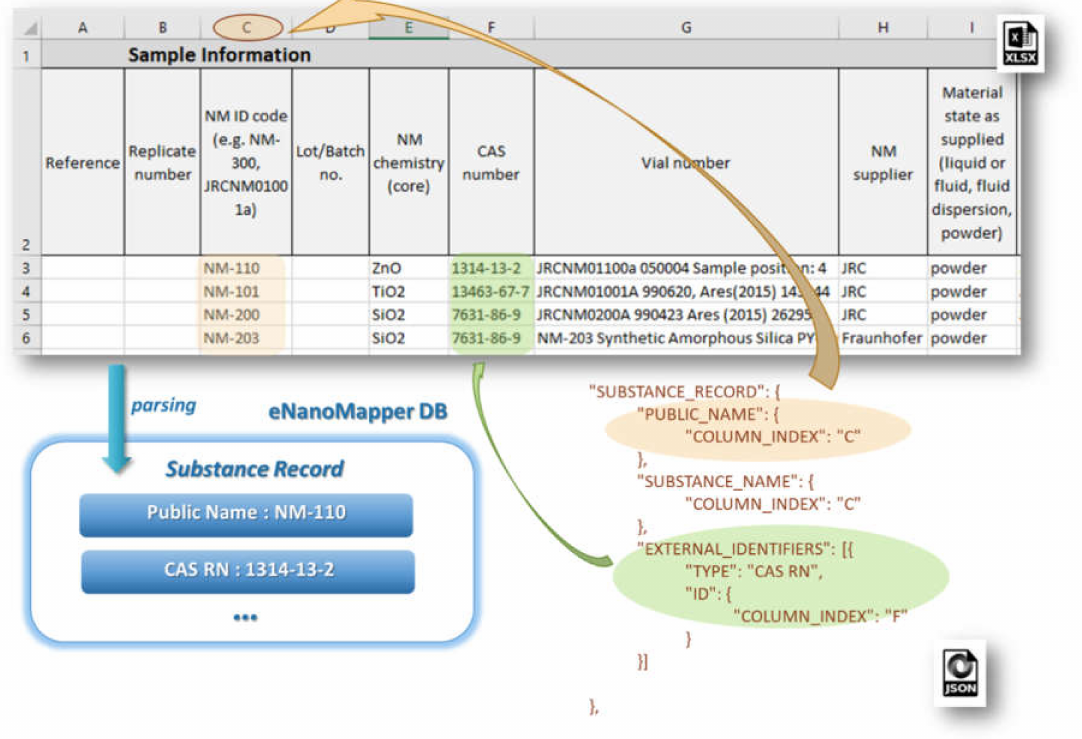
Figure 7. Mapping Excel data with EDLs in the iteration mode ROW_SINGLE and iterating Substance